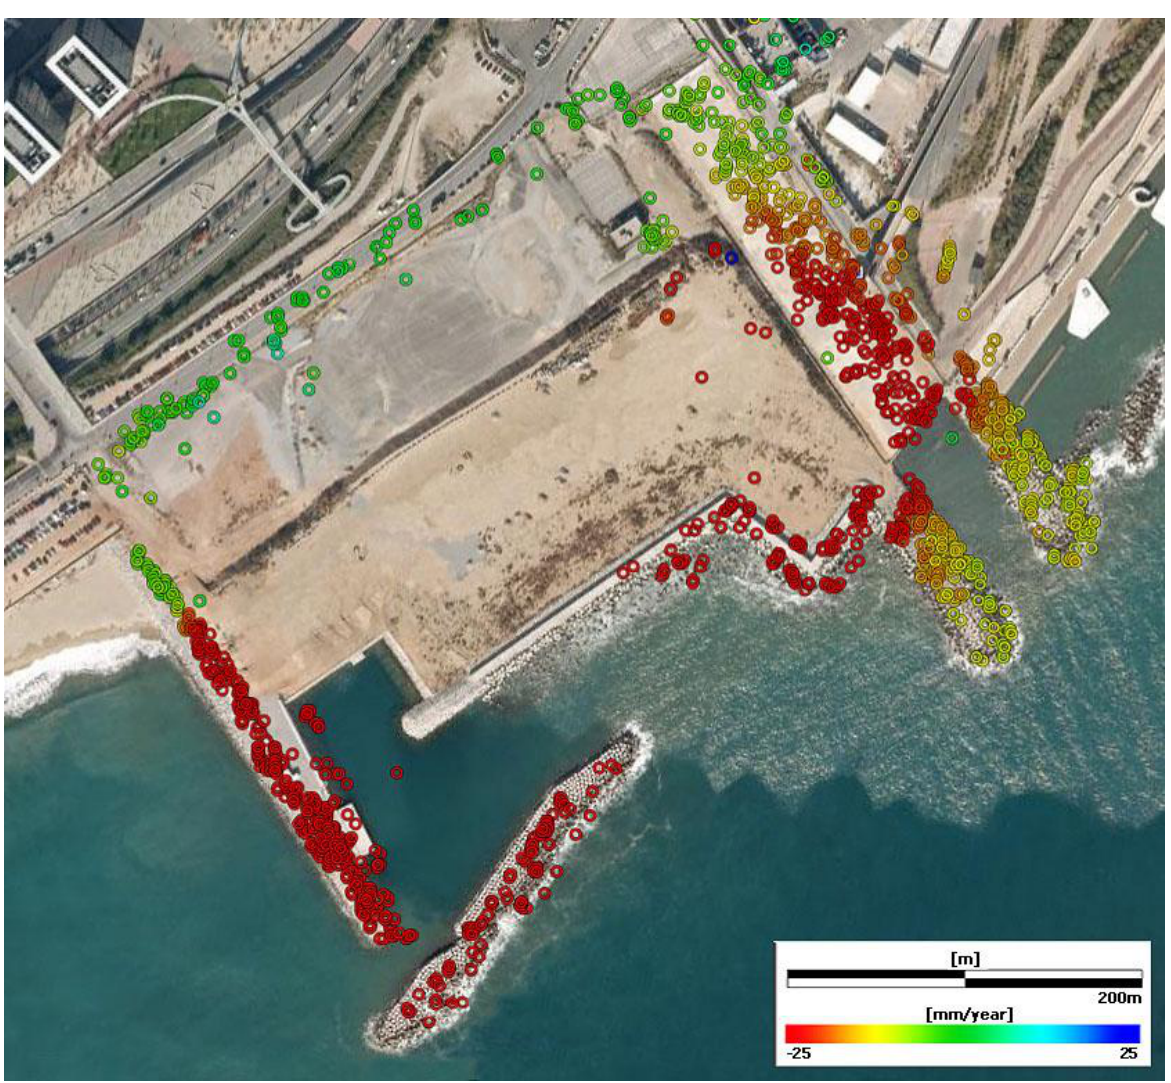
Figure 5. Geocoded deformation velocity map superimposed over a Google Earth image (© 2009 Google, Institut Cartogràfic de Catalunya). The covered area is the new marine Zoo of Barcelona, which is under